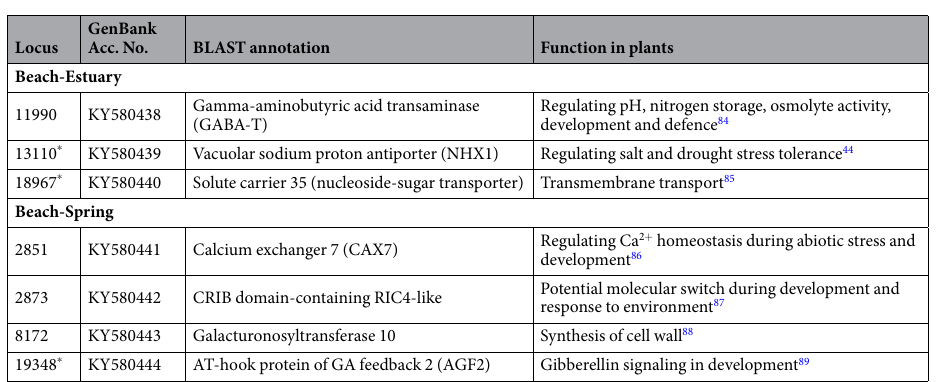
Table 2. GenBank accession numbers and annotation information for outlier loci from ecotype comparisons. BLAST annotation is given for outlier loci that were found in both beach-estuary comparisons (i.e. within Troms and within Lofoten) and in both beach-spring comparisons. Outlier loci marked with an asterisk were not specific for a particular ecotype comparison (see Supplementary Information Table